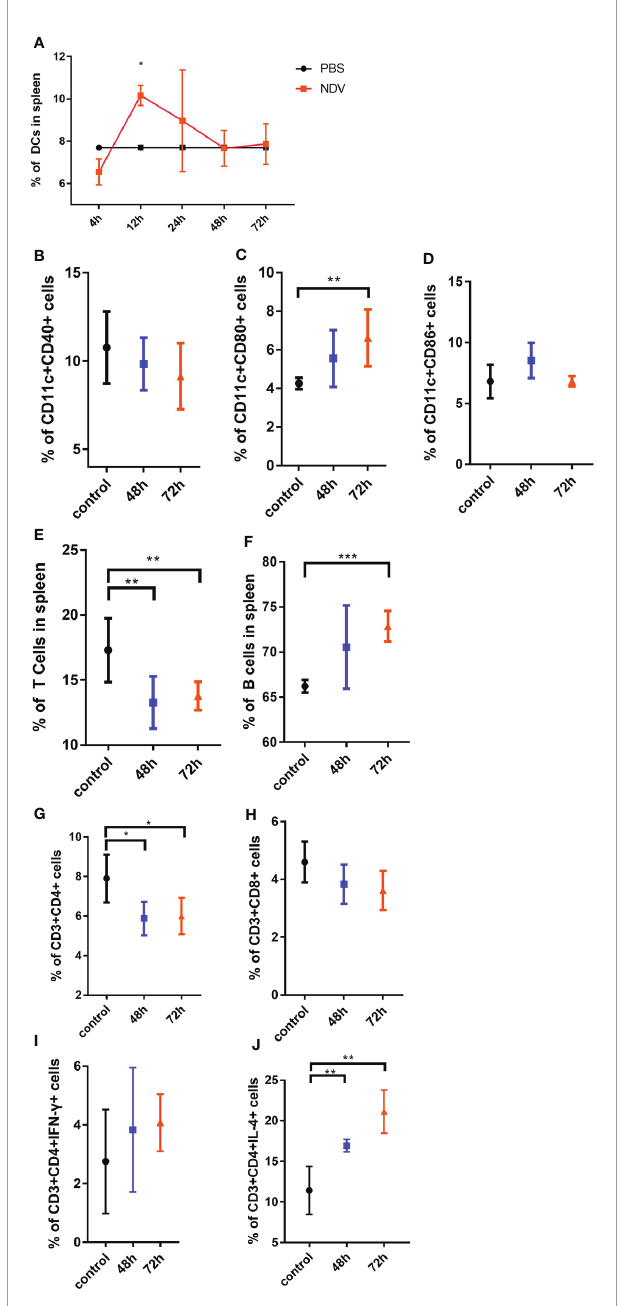
FIGURE 5 | In vivo analysis of maturation of DCs and activation of T cells driven by NDV. Mice were inoculated with 100 µl of 10 7.3 TCID 50 NDV and the spleen samples were isolated at indicated times. The ratios of DCs from spleens were measured by the speci fi c marker (CD3 - CD11c + and MHC-II + ) through fl ow cytometry analysis (A) . The proportions of CD11c + CD40 + cells (B) , CD11c + CD80 + cells (C) , CD11c + CD86 + cells (D) were analyzed by fl ow cytometry. The portions of CD3 + T cells (E) , CD19 + B cells (F) , CD3 + CD4 + cells (G) , CD3 + CD8 + cells (H) , CD3 + CD4+ cells secreting IFN- g (I), and CD3 + CD4 + cells secreting IL-4 (J) in the spleen were shown. All experiments were performed independently at least thrice and results were presented as means ± standard deviation. Signi fi cance levels were de fi ned as *p < 0.05, **p < 0.01 and ***p <